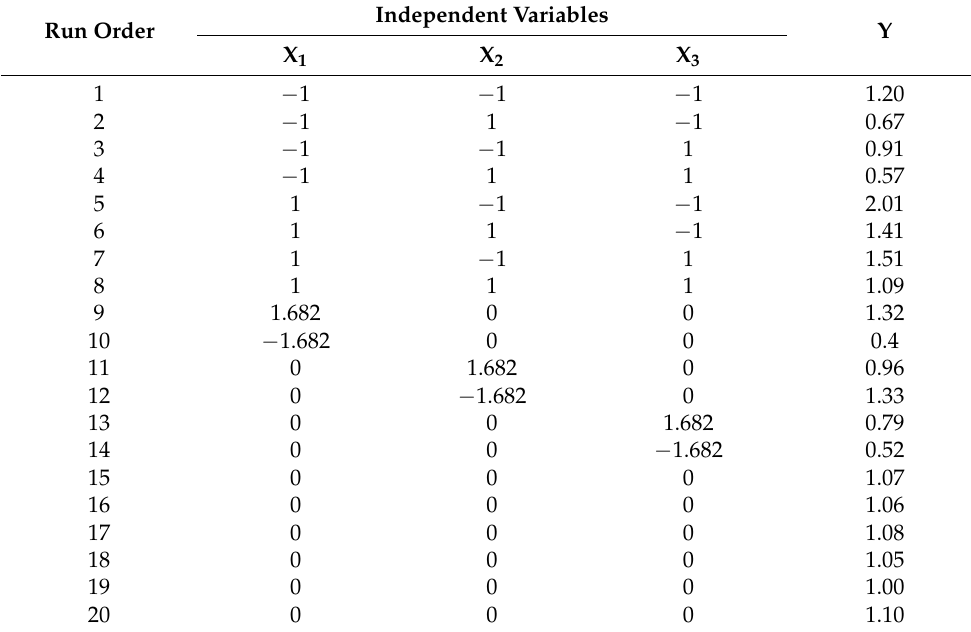
Table 4. Experimental design and results of the